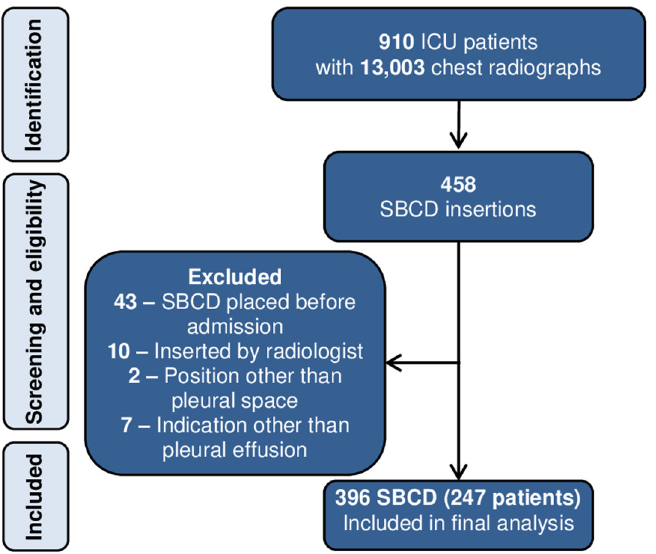
Figure 1. Screening and eligibility flow chart. ICU: Intensive care unit; SBCD: Small bore chest drain. Table 1. Demographics a of patient population ( n = 247).